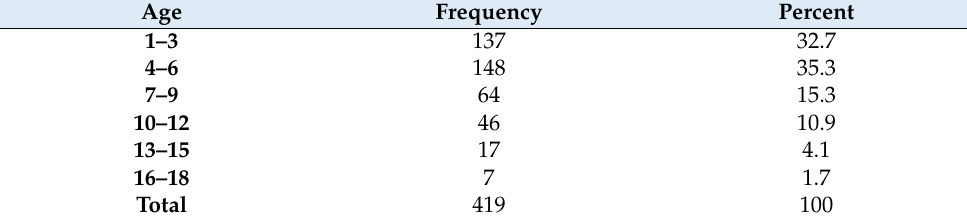
Table 1. Frequency and percentage of